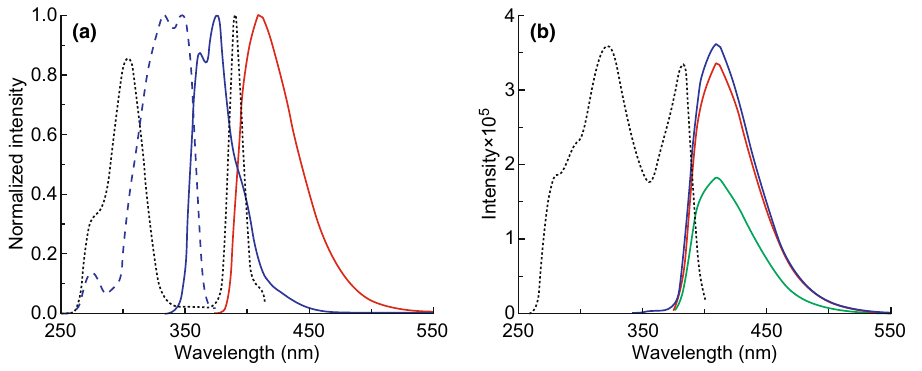
Fig. 7 a Excitation (dashed lines) and emission (solid lines) spectra of free NDC (blue) and DPTTZ (red) ligands showing the requisite spectral overlap for FRET. b Excitation (dashed black line) and emission spectra of Zn 2 (NDC) 2 (DPTTZ) showing exclusively DPTTZ-centric emission regardless of excitation wavelengths ( λ Ex = 320 (blue), 350 (green), and 380 nm (red)). Reprinted with permission from Ref. [36]. Copyright 2019, American Chemical Society. (Color figure